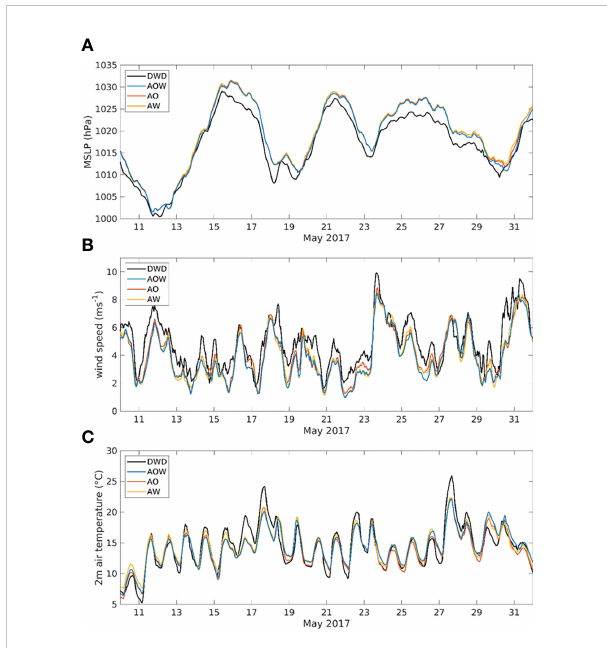
FIGURE 12 Time series of the MSLP (A) , 10-m wind speed (B) , and 2-m air temperature (C) averaged over the DWD stations in the German